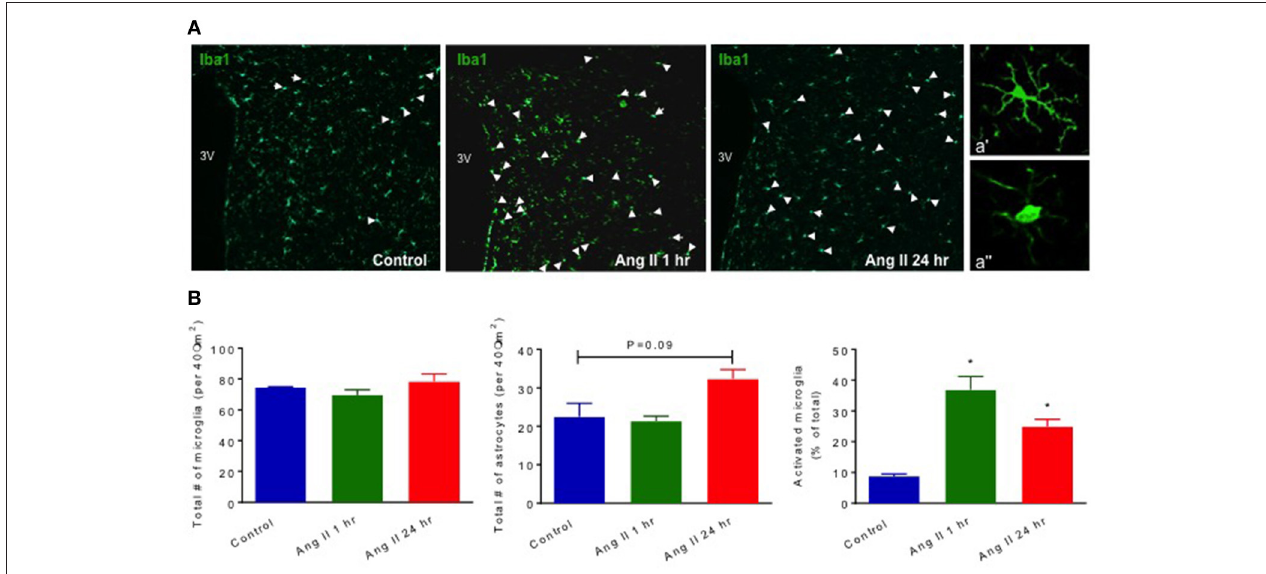
FIGURE 3 | Effect of systemic Ang II injection on microglial activation and astrocytes in the PVN. Quantification of Iba1 + microglial cells in the PVN of WKY shows an increase in activated microglia at 1 and 24 h following Ang II injection (in B , far right). Quantification of total GFAP + astrocytes following Ang II injections showed a trend in increase at 24 h post-Ang II-injection (in B , middle graph). Representative images of PVN microglial cells at three different time points are shown in (A) . White arrow points to activated microglial cells in Control, and 1 and 24 h following Ang II injections. Higher magnification (40x) images of representative resting and activated microglia are shown in a’ and a” respectively. ± SEM. N = 4 per group, * p < 0.05 vs.